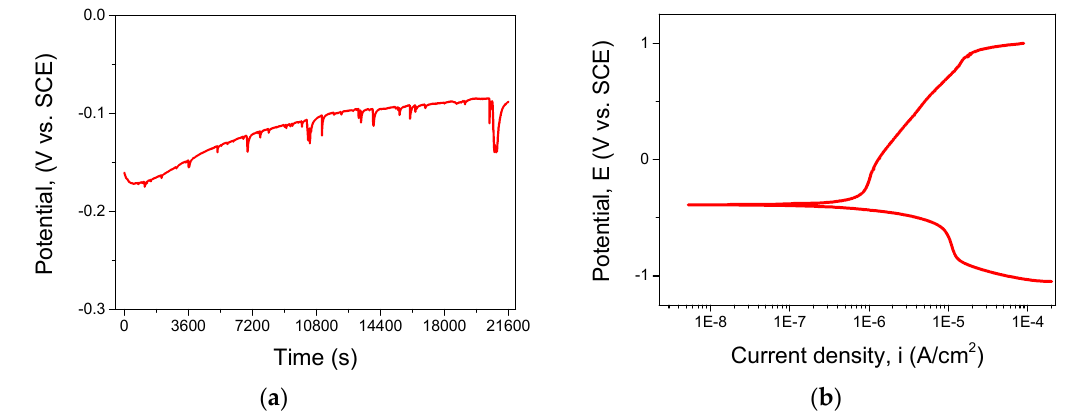
Figure 4. ( a ) Open circuit potential variation and ( b ) potentiodynamic polarization curve for the bulk CoCrFeNiMo alloy tested electrochemically in 3.5% NaCl solution.